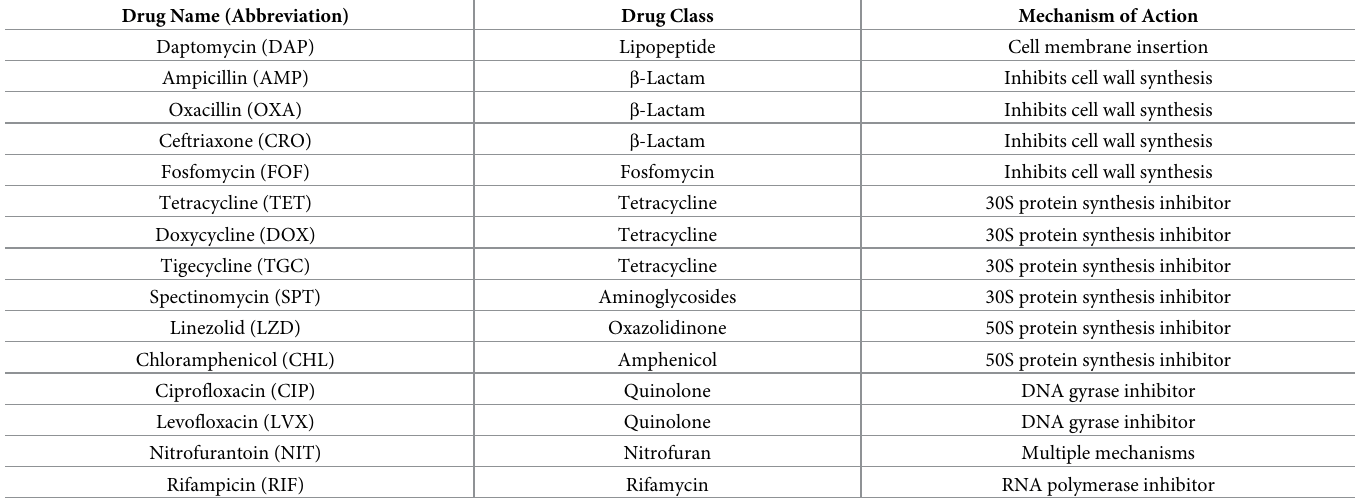
Table 1. Table of antibiotics used in this study and their